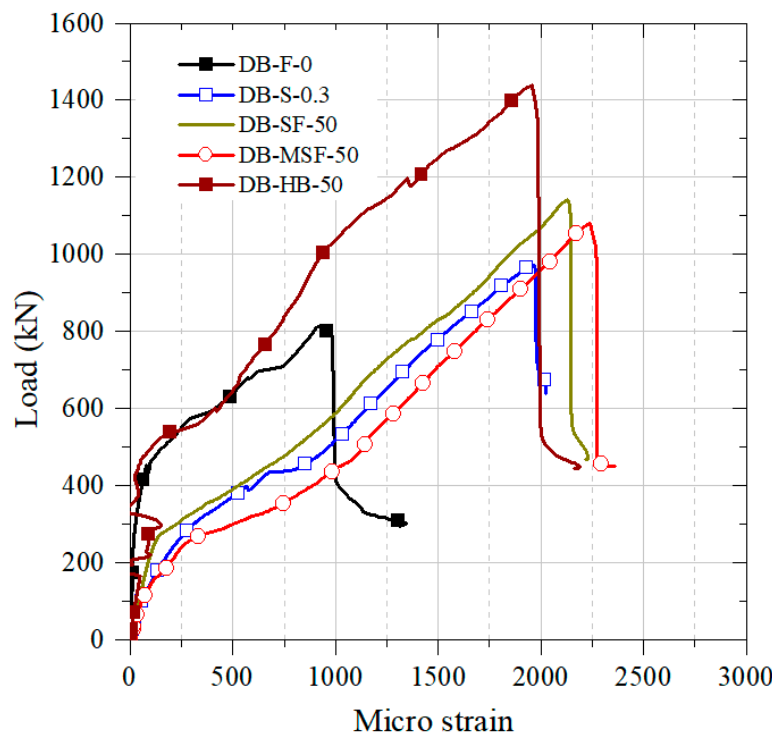
Figure 12. Strains in longitudinal tension reinforcement at mid-span.